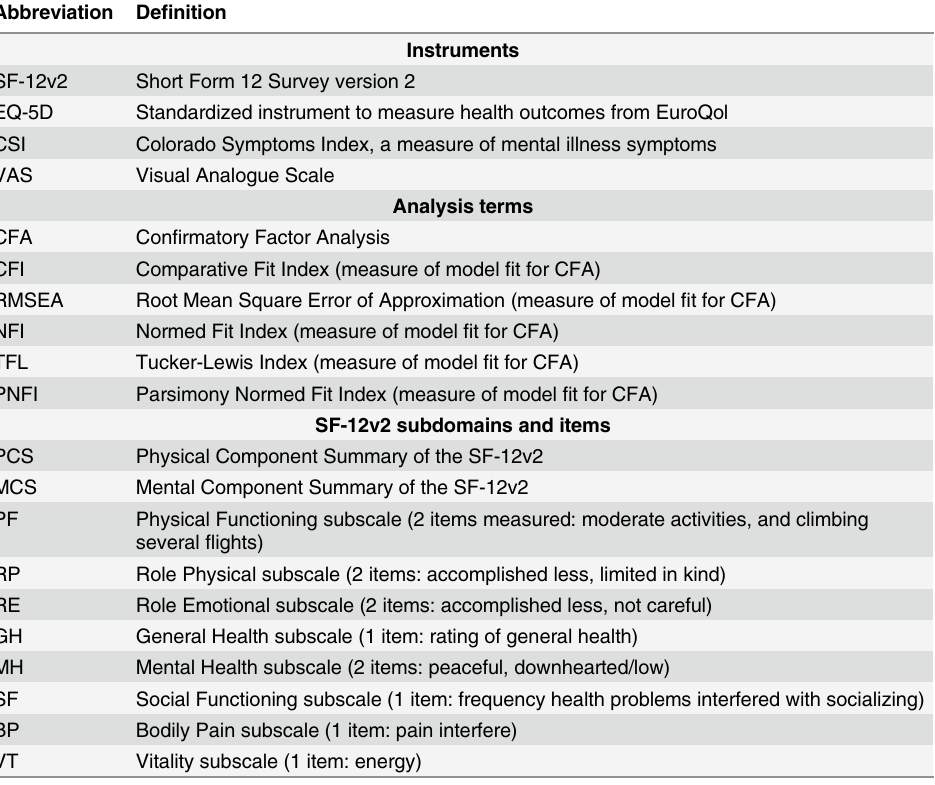
Table 1. Abbreviations and description of SF-12v2 subdomains and